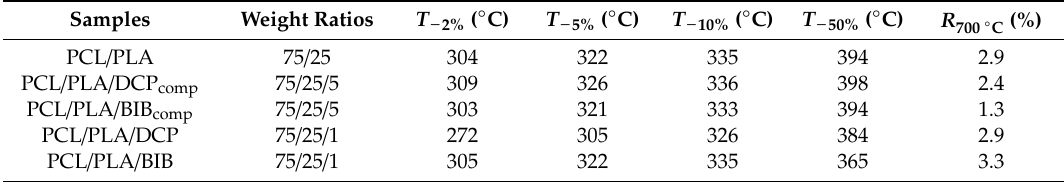
Figure 4. Results of TGA thermograms for PCL / PLA blends. Table 1. Thermal degradation parameters of PCL / PLA